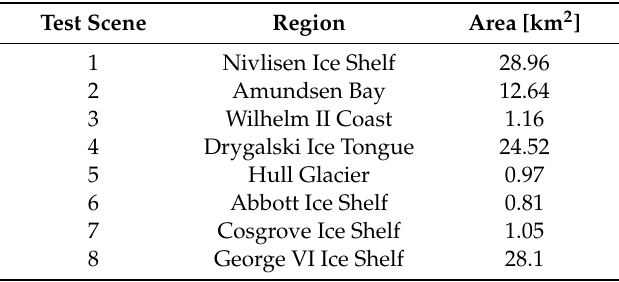
Table 4. Area covered by supraglacial meltwater features within the full Sentinel-2 test